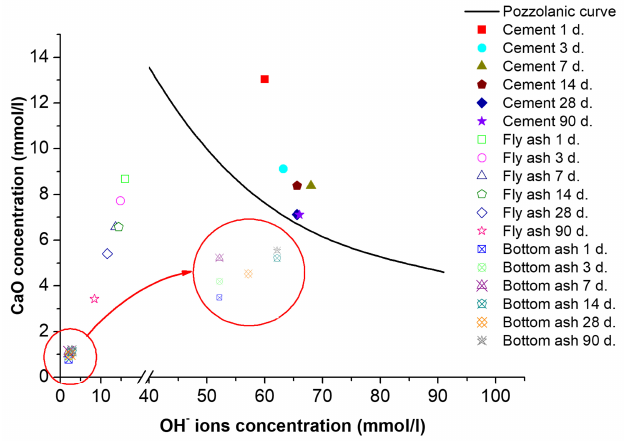
Figure 3. Constituents pozzolanicity at 1, 3, 7, 14, 28 and 90